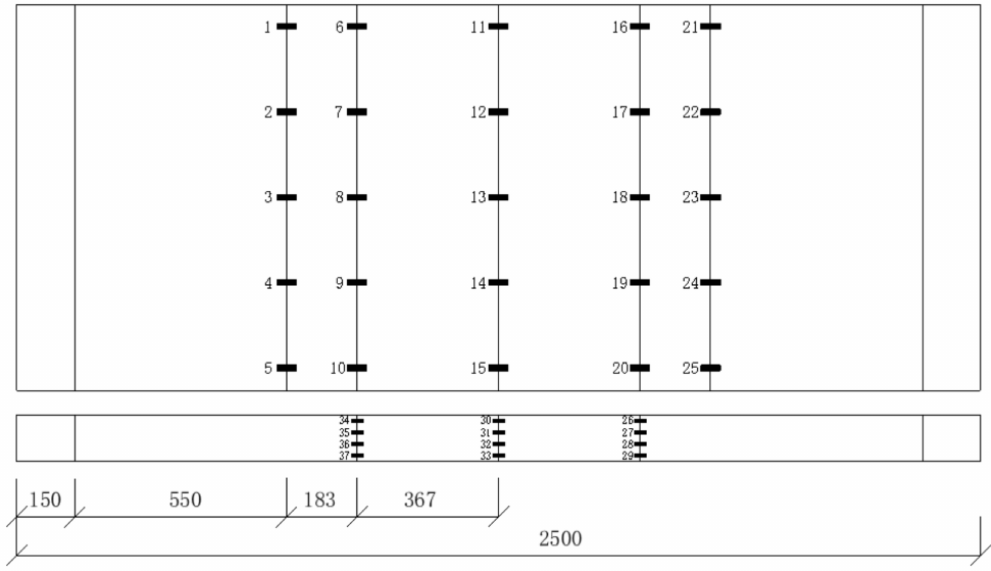
Figure 7. Arrangement of strain